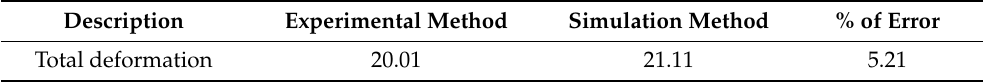
Table 7. Comparative